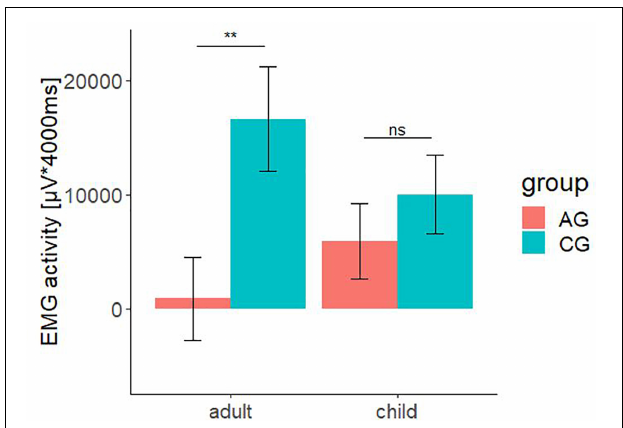
FIGURE 6 | Electromyographic activity ( µ V × ms) over entire measurement interval (0–4000 ms) for the interaction effect consisting of the between-subject-factors group (AG and CG) and the within-subject factors age (children and adult faces). A significant lower EMG-activity was found for the AG in response to faces of adult. Negative EMG activity is caused by the baseline correction; error-bars represent the standard error. The symbol ** indicates p < 0.01. ns indicates not